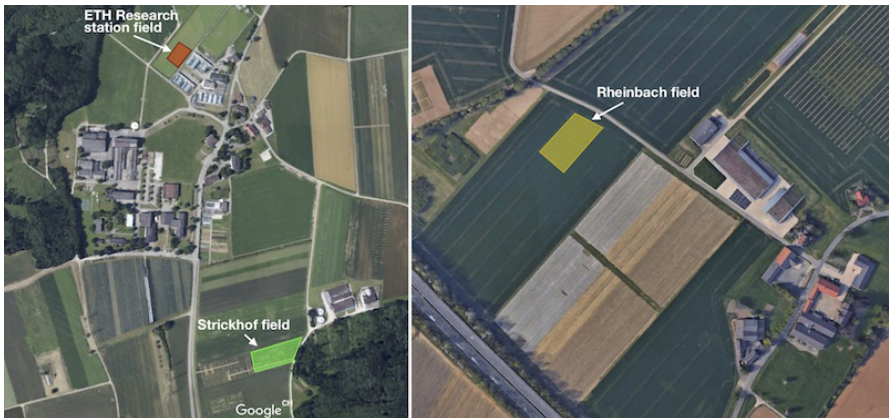
Figure 2. Sugar beet fields where we collected datasets. Two fields in Eschikon are shown on the left, and one field in Rheinbach is on the right.